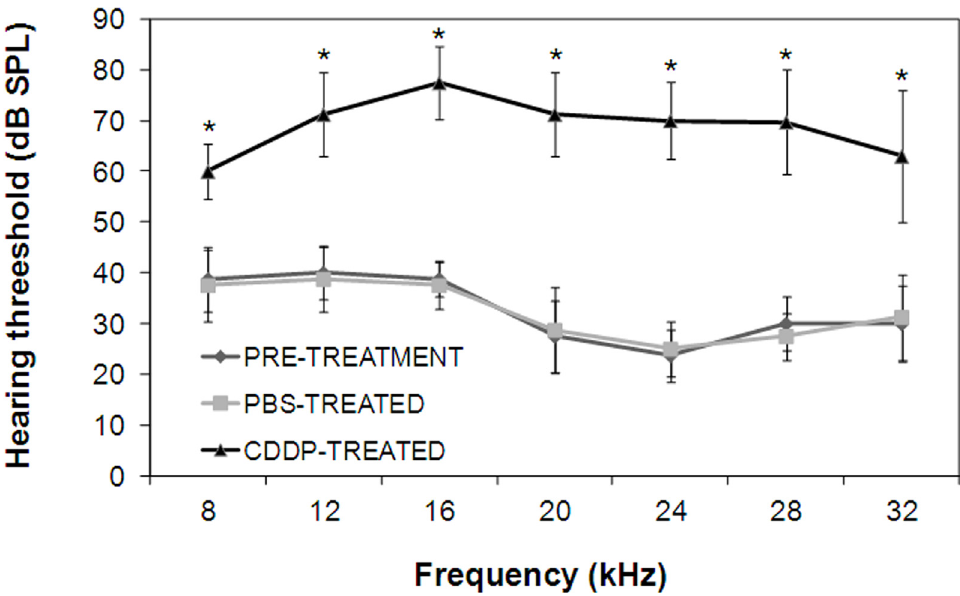
Fig 1. Hearing thresholds before and after intraperitoneal administration of 10 mg/kg dose of CDDP or PBS. CDDP-induced hearing loss was statistically significant for all frequencies with respect to pre-treatment hearing. The diagrams include the mean, the standard deviation (n = 33), and the ANOVA results (difference statistically significant respect tectorial membrane * p < 0.05).